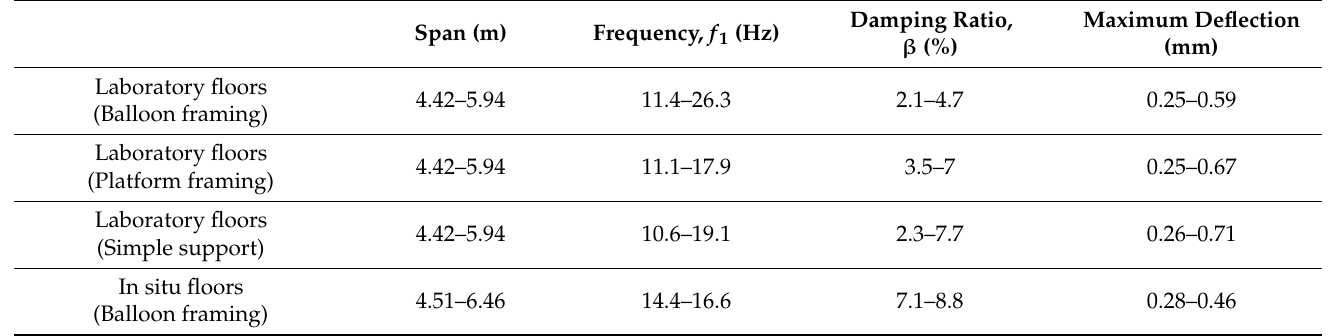
Table 3. The static and dynamic results for laboratory and in situ floors with various conditions of subfloor, joist type, ceiling, and strongback, evaluated by Parnell et al. [35]. Damping Ratio, Span (m) Frequency, f 1 (Hz)